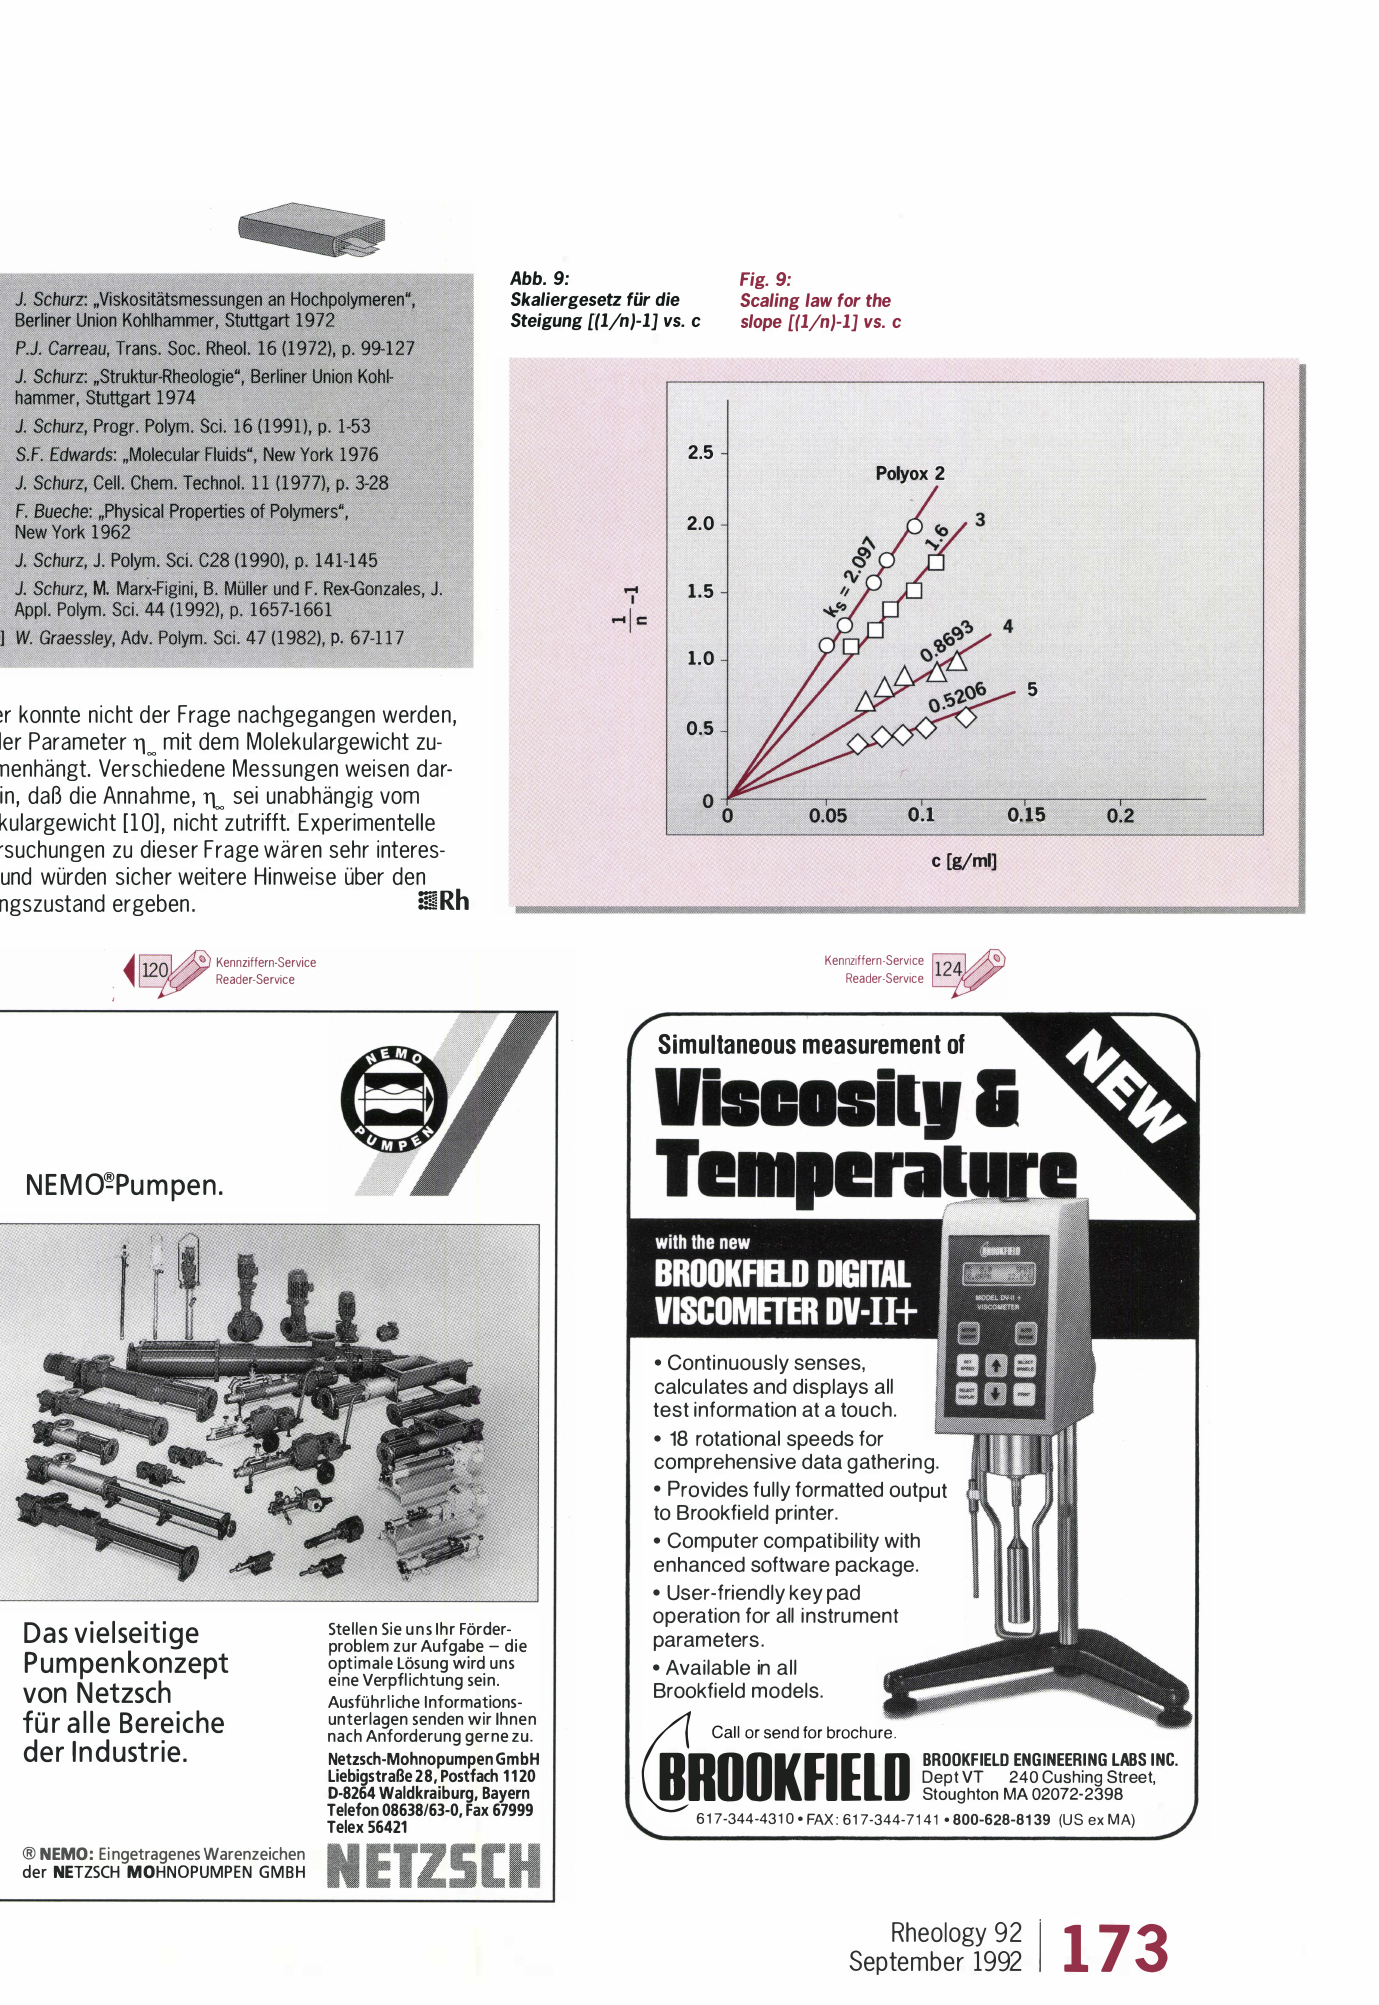
Fig. 9: Skaliergesetz fur die Scaling law for the Steigung [(1/n}-1] vs. c slope [(1/n}-1] vs.